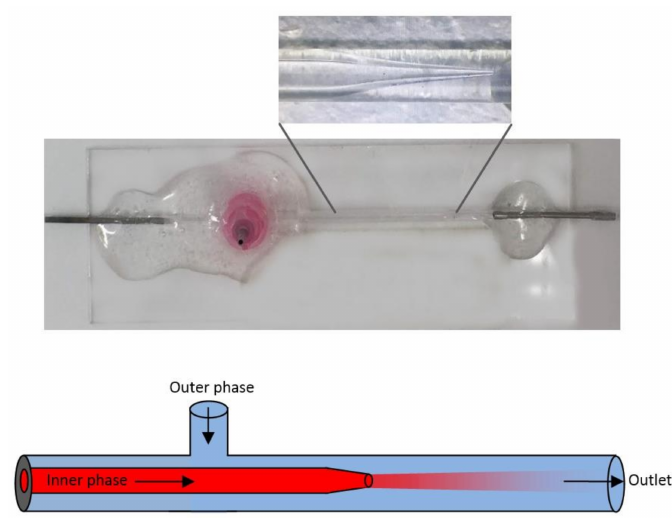
Figure 7. Designed microfluidic